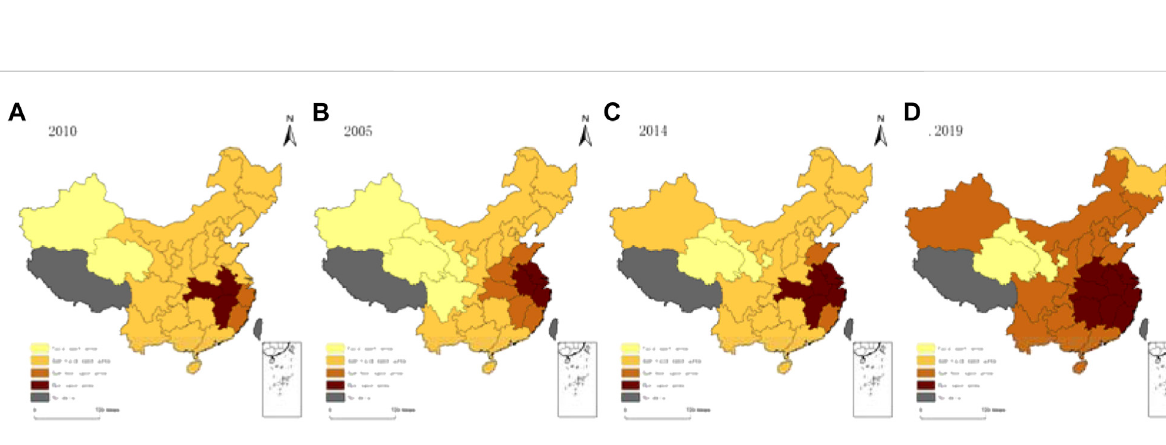
FIGURE 5 Cold and hot spot areas of the coupling coordination degree. (A) 2010, (B) 2005, (C) 2014, (D)